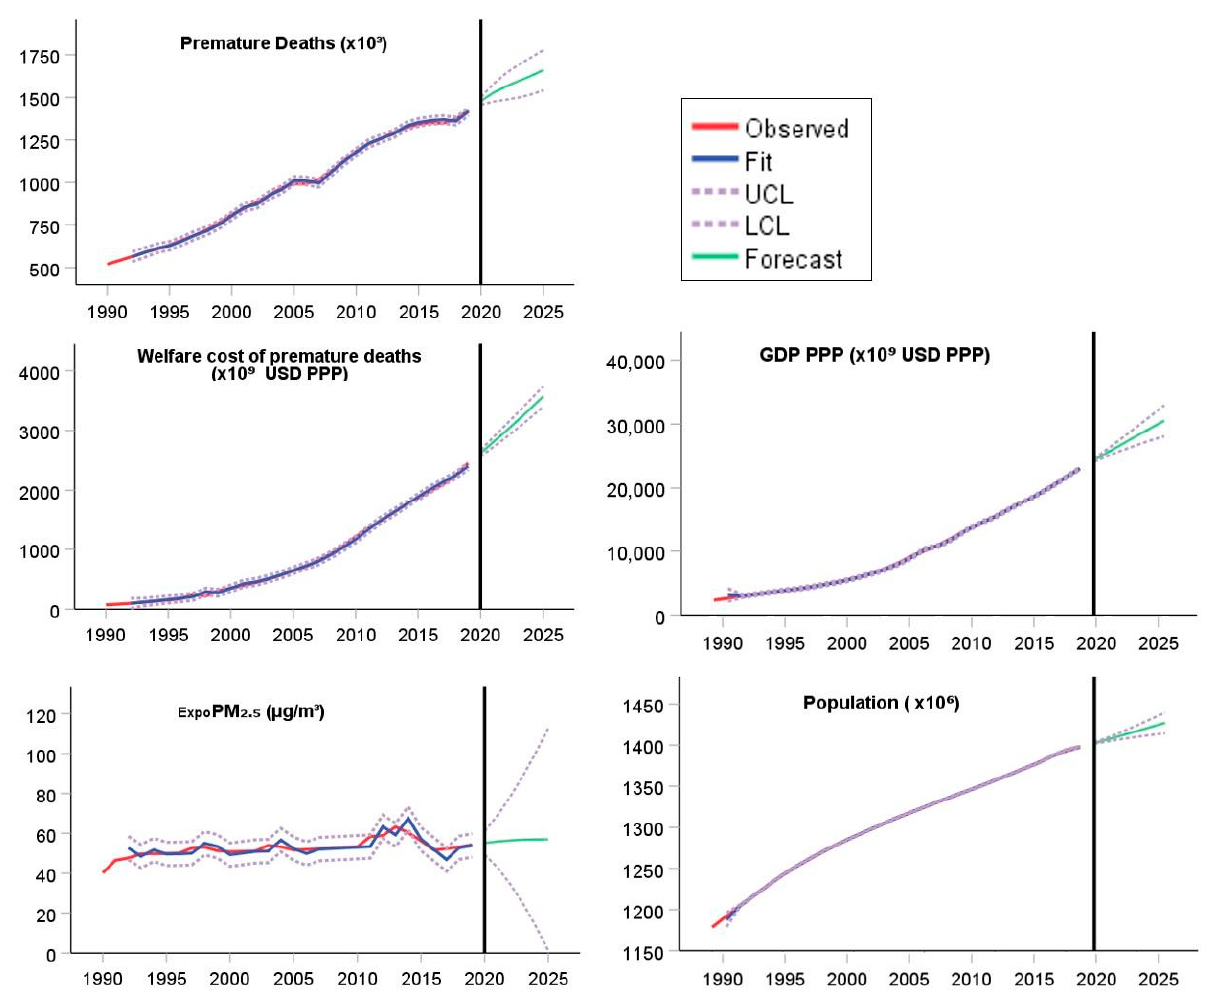
Figure 13. Projection results from ARIMA models for five parameters from 2020 to 2025, without including effects of COVID-19 lockdown control measures on air quality. Fit: measured discrepancies between observed and model generalizations; LCL: lower control limit; UCL: upper control limit; Forecast: estimated future dataset.